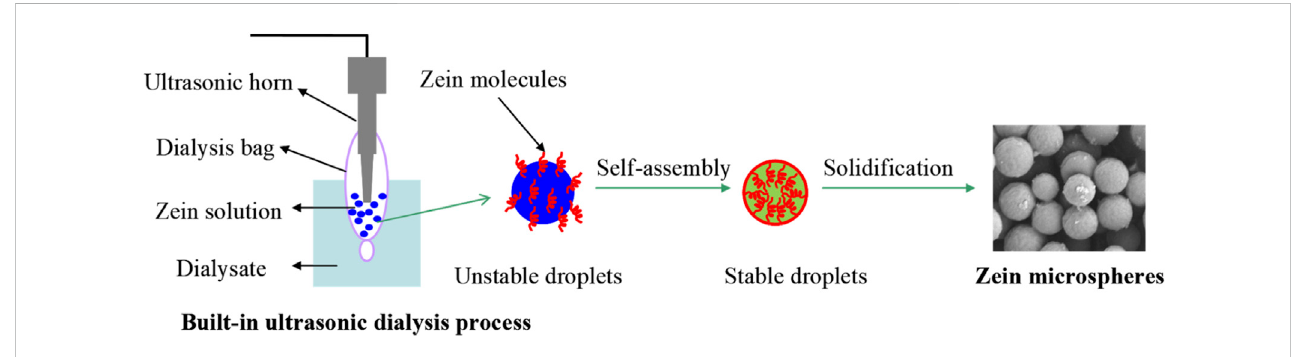
FIGURE 2 Self-assembly of zein microspheres using built-in ultrasonic dialysis